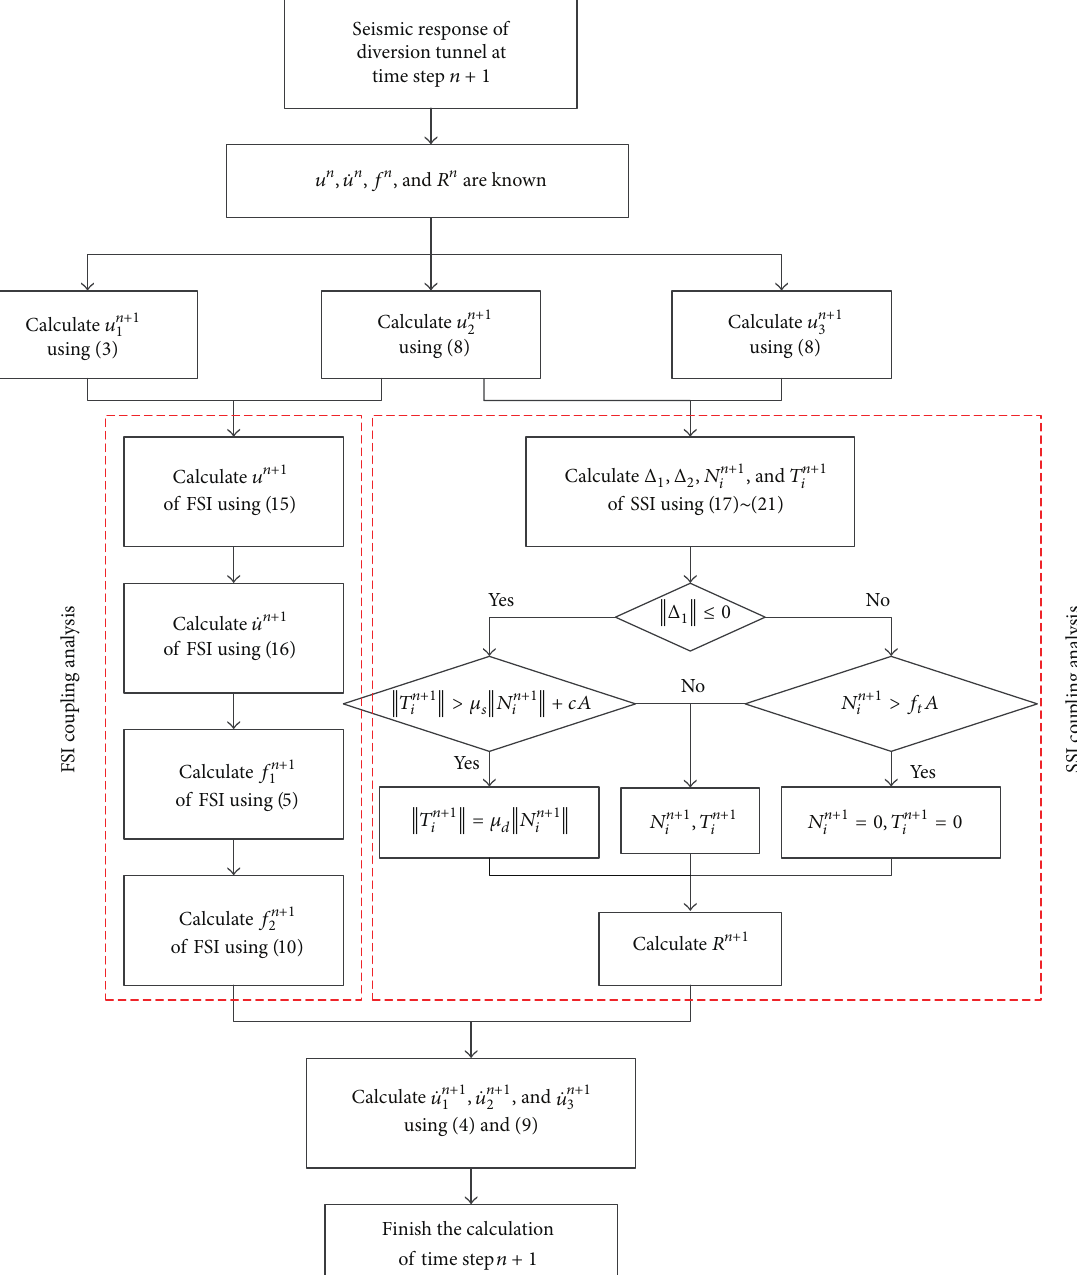
Figure 2: The flow chart of fluid-lining-rock coupling interaction analysis of diversion tunnel.